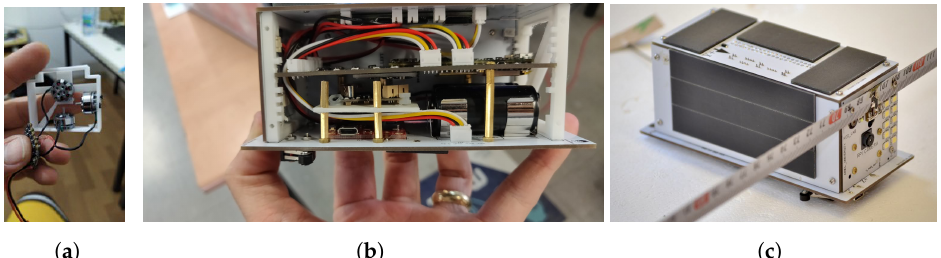
Figure 8. The FSO pico-satellite engineering model. ( a ) The attitude control unit, composed of three tiny reaction wheels, one for each axis, and a tiny flight controller with IMU for controlling each motor. ( b ) SATLLA-2.0 pico-satellite under construction. ( c ) The final model of SATLLA-2B pico-satellite, with its LEDs, camera, laser, UHF antenna, and solar panels. This model was recently successfully launched into